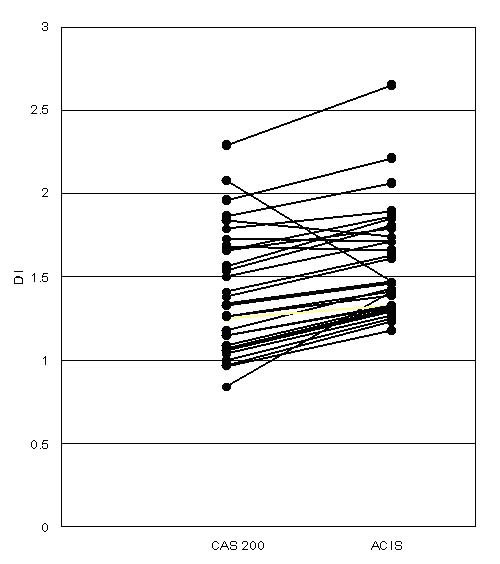
Comparison of DI values as determined by the CAS 200 and ACIS methods in various Barrett's lesions (p < 0.001, paired t test). Dots represent individual sections examined by both instruments.